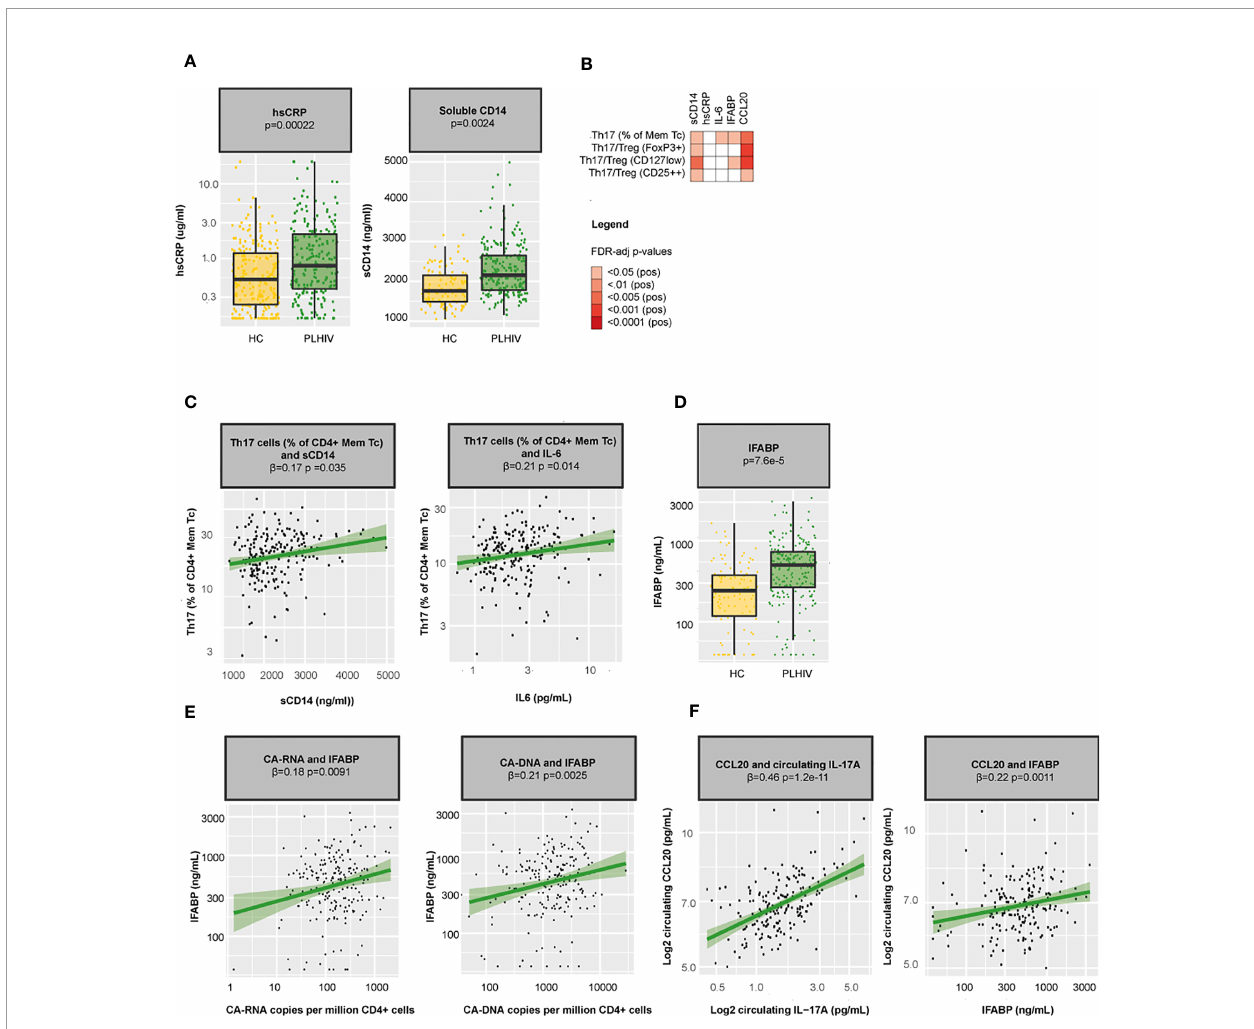
FIGURE 5 | In fl ammation, microbial translocation, and Th17 cells in PLHIV (A) Boxplots showing differences in hsCRP and sCD14 between PLHIV (n=211) and healthy controls (n=56). (B) Heatmap showing associations between Th17 percentages, Th17/Treg ratios and sCD14, hsCRP, IFABP, and CCL20. (C) Associations between Th17 percentages and sCD14 and circulating IL-6 in PLHIV. (D) Levels of the microbial translocation marker IFABP in PLHIV and healthy controls. (E) Associations between IFABP and CA-RNA and CA-DNA in PLHIV. (F) Associations between CCL20 and circulating IL-17A and IFABP. Inverse-rank transformed data were analyzed using linear regression analyses and corrected for sampling time. CA-DNA, CD4-cell-associated HIV-1 DNA; CA-RNA, CD4-cell-associated HIV-1 RNA; CCL20, Chemokine (C-C motif) ligand 20; HC, healthy control; hsCRP, high-sensitivity CRP; IFABP, intestinal fatty-acid binding protein; IL-6, interleukin 6; IL-17A, interleukin 17A; Mem Tc, CD4+ memory T cell; PLHIV, people living with HIV; sCD14, soluble CD14; Th17 percentages, T-helper 17 cell percentages (Mem Tc CCR6+ CXCR3-CCR4+ as percentage of CD4+ Mem Tc); Treg, regulatory T cells; WBC, white blood